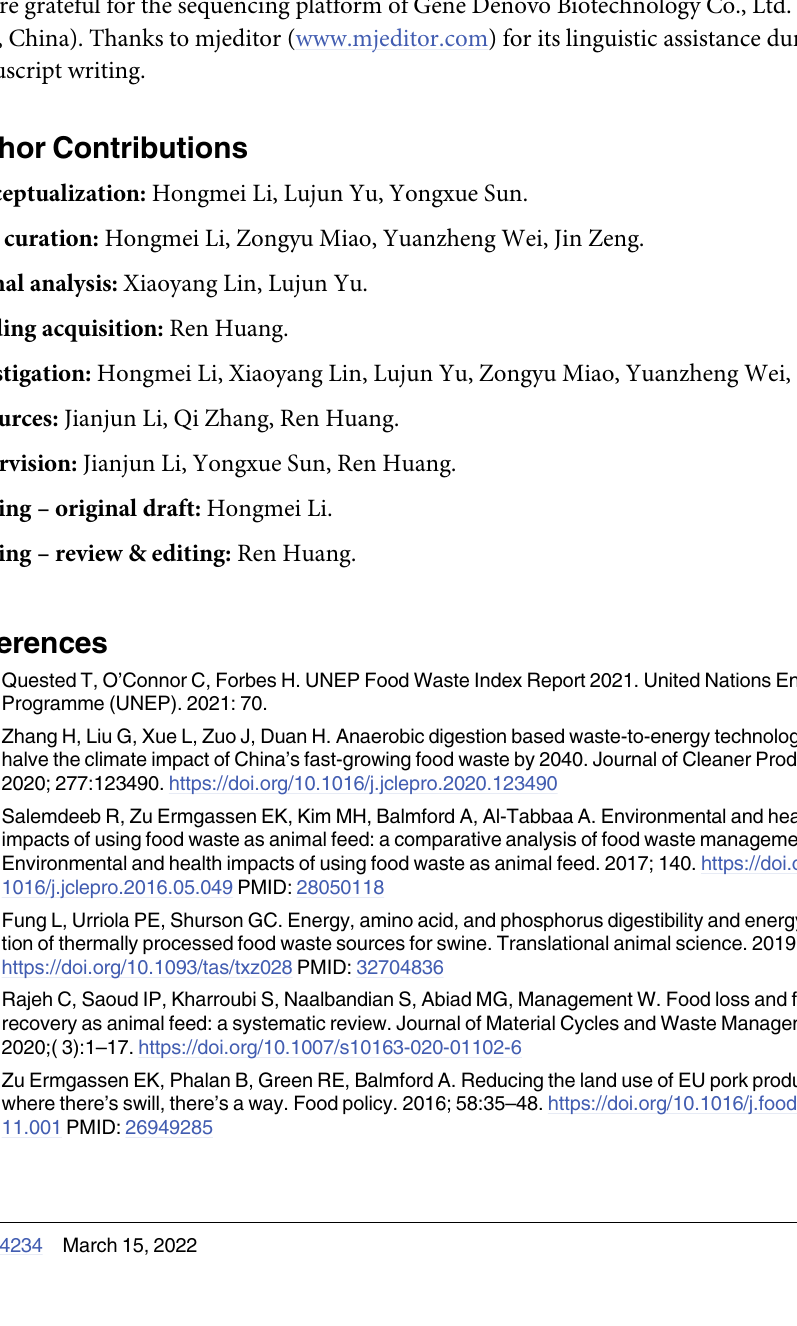
S1 Fig. Schematic diagram of the experimental setup. S1 Table. Identification of significant key metabolites by LC-MS in fermented food waste sample. S2 Table. Identification of significant key metabolites by GC-MS in fermented food waste